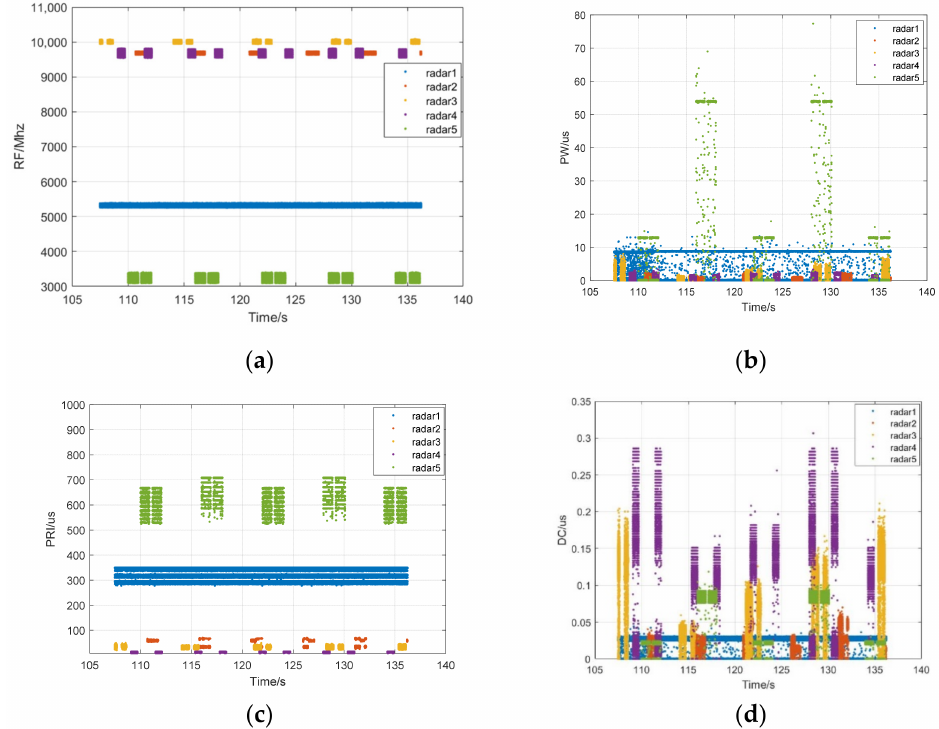
Figure 5. The data parameter distribution. ( a ) RF distribution; ( b ) PW distribution; ( c ) PRI distribu- tion; and ( d ) DC